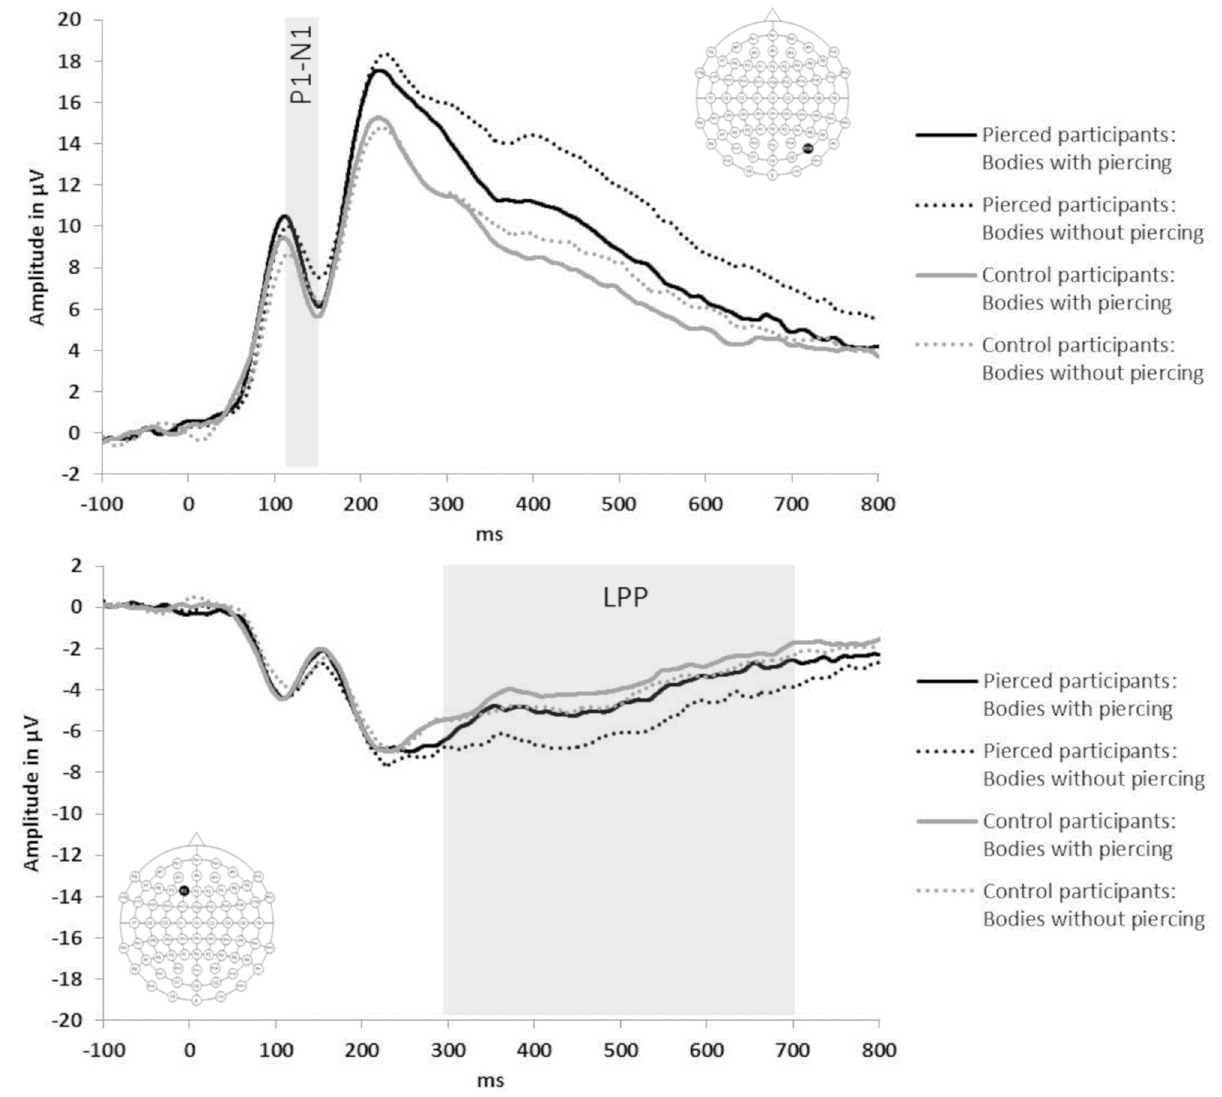
Fig 4. Visual ERPs to images of other women’s abdomens with (solid waveforms) and without (dotted waveforms) navel piercings obtained during the aesthetic ratings task from participants with (black waveforms) and without (grey waveforms) navel piercings. Top panel shows right- hemispheric posterior electrode PO8; bottom panel shows left frontal electrode F1 (see insets for electrode locations). than bodies without piercings (12.6 μ V), and larger for images of the self (14.4 μ V) than of other women’s bodies (12 μ V). There were significant interactions between identity and hemi- sphere, F(1,15) = 6.5, p = .022, η p2 = .30, 1- β > .99, between piercing and electrode, F(4,60) = 6.4, p = .002, η p2 = .30, 1- β > .99, and a four-way interaction between identity, piercing, hemi- sphere and electrode, F(4,60) = 3.48, p = .030, η p2 = .19, 1- β > .99. Pairwise comparisons of the estimated marginal means of self and other at each level of piercing, hemisphere and electrode showed that the P1-N1 enhancement for self-body images compared to other-body images with piercings was restricted to right-hemisphere electrodes (all F(1,15) � 5.3, p � .036, η p2 � .26, 1- β > .99) and to left-hemisphere electrode O1 (F(1,15) = 4.7, p = .047, η p2 = .24, 1- β > .99; all other left-hemisphere electrodes F(1,15) � 3.6, p � .077, η p2 � .19, 1- β > .99). In contrast, P1-N1